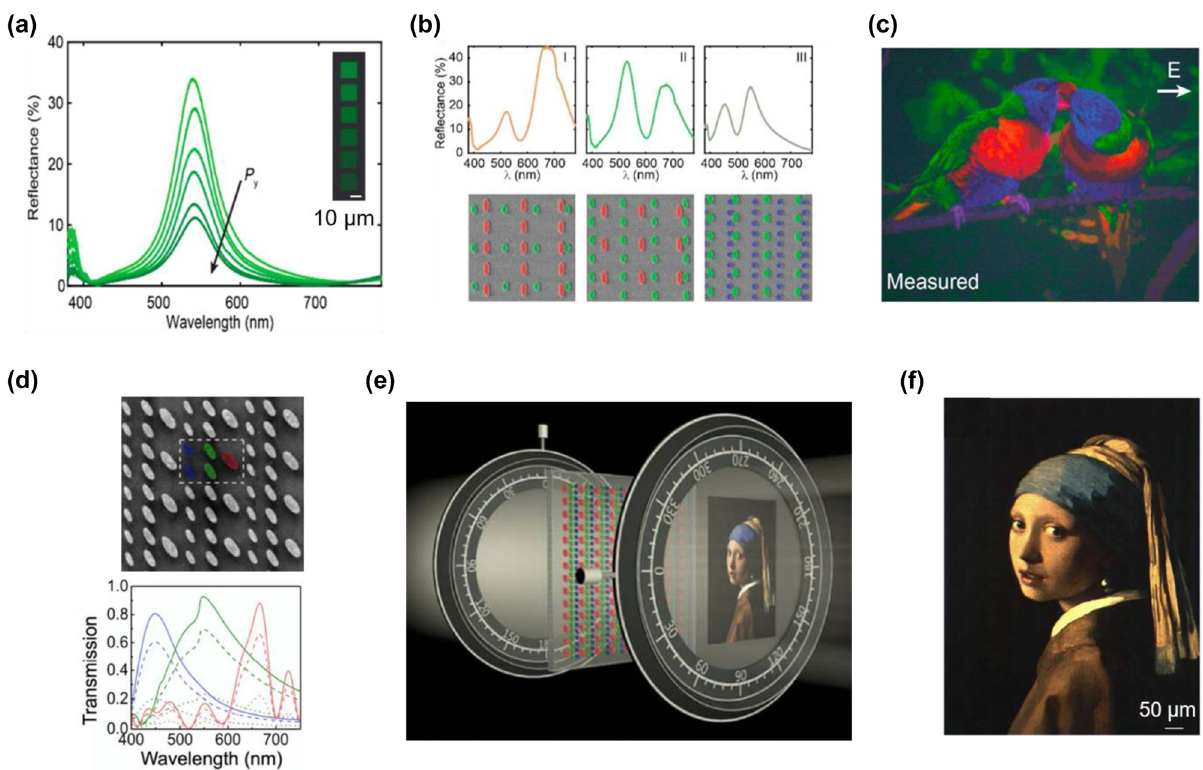
Figure 36: Structural color printing with pixels of tunable brightness. (a) Measured reflectance spectra of green-color Ag nanorod pixel arrays, where ). Insets: associated bright-field microscope images of the luminance decreases with the increase of lattice spacing along the rod’s long axis ( P y different samples. (b) Measured reflection spectra (upper panel) and corresponding false-colored SEM images (lower panel) of the mixed nanorod arrays. (c) Optical bright-field image of a fabricated sample showing two colorful parrots. The sample consists of nanorod arrays with tunable brightness and chromaticity. The illumination light is linearly polarized along the rod’s long axis (as the arrow indicates). The fabricated sample is 240 × 312 μ m in size, and its square pixel has a side length of 1.28 μ m. Modified with permission [342]. Copyright 2020, American Chemical Society. (d) Upper panel: SEM image of a fabricated sample consisting of TiO nanopillars. A super-cell is enclosed by white dashed lines and the false coloring 2 of nanopillars indicates the primary colors that are generated by the respective nanopillars. Scale bar: 500 nm. Lower panel: Calculated transmission spectra corresponding to red (red curves), green (green curves), and blue (blue curves) colors when the nanopillar orientation angle varies from 45 ◦ (solid lines) to 30 ◦ (dashed lines) and 15 ◦ (dotted lines). (e) Illustration of the experimental setup for full-color printing, where a linear polarizer is placed behind the metasurface to decode the generated colors. (f) Reproduction of the painting “girl with a pearl earring”. Scale bar: 50 μ m. Modified with permission [244]. Copyright 2020, Optica Publishing